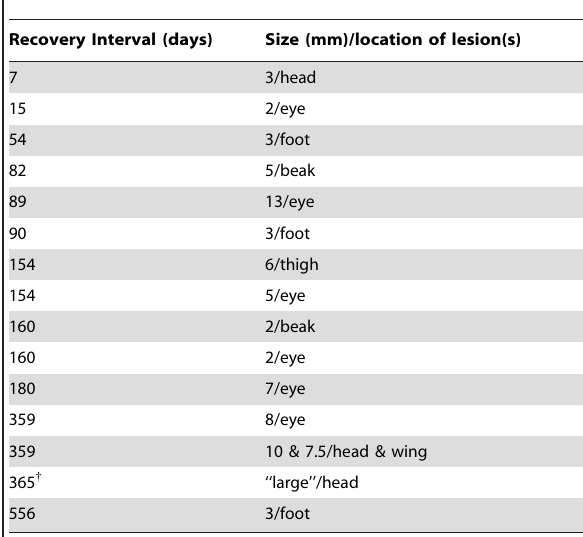
Table 4. Details of birds that recovered from